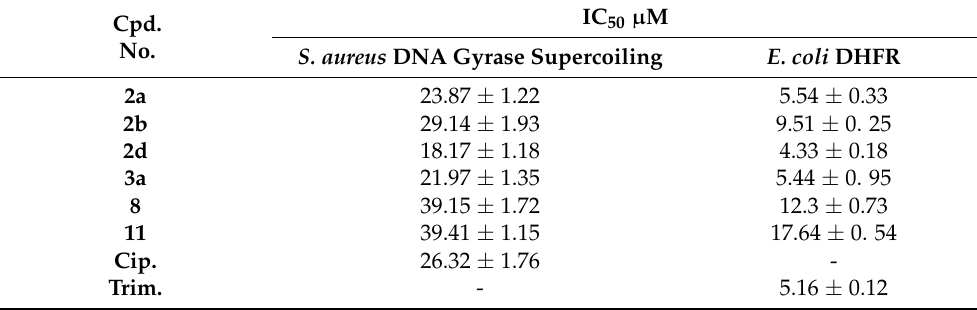
Table 6. Determination of the enzyme assay of the most promising compounds against both S. aureus DNA gyrase and E. coli DHFR inhibitory